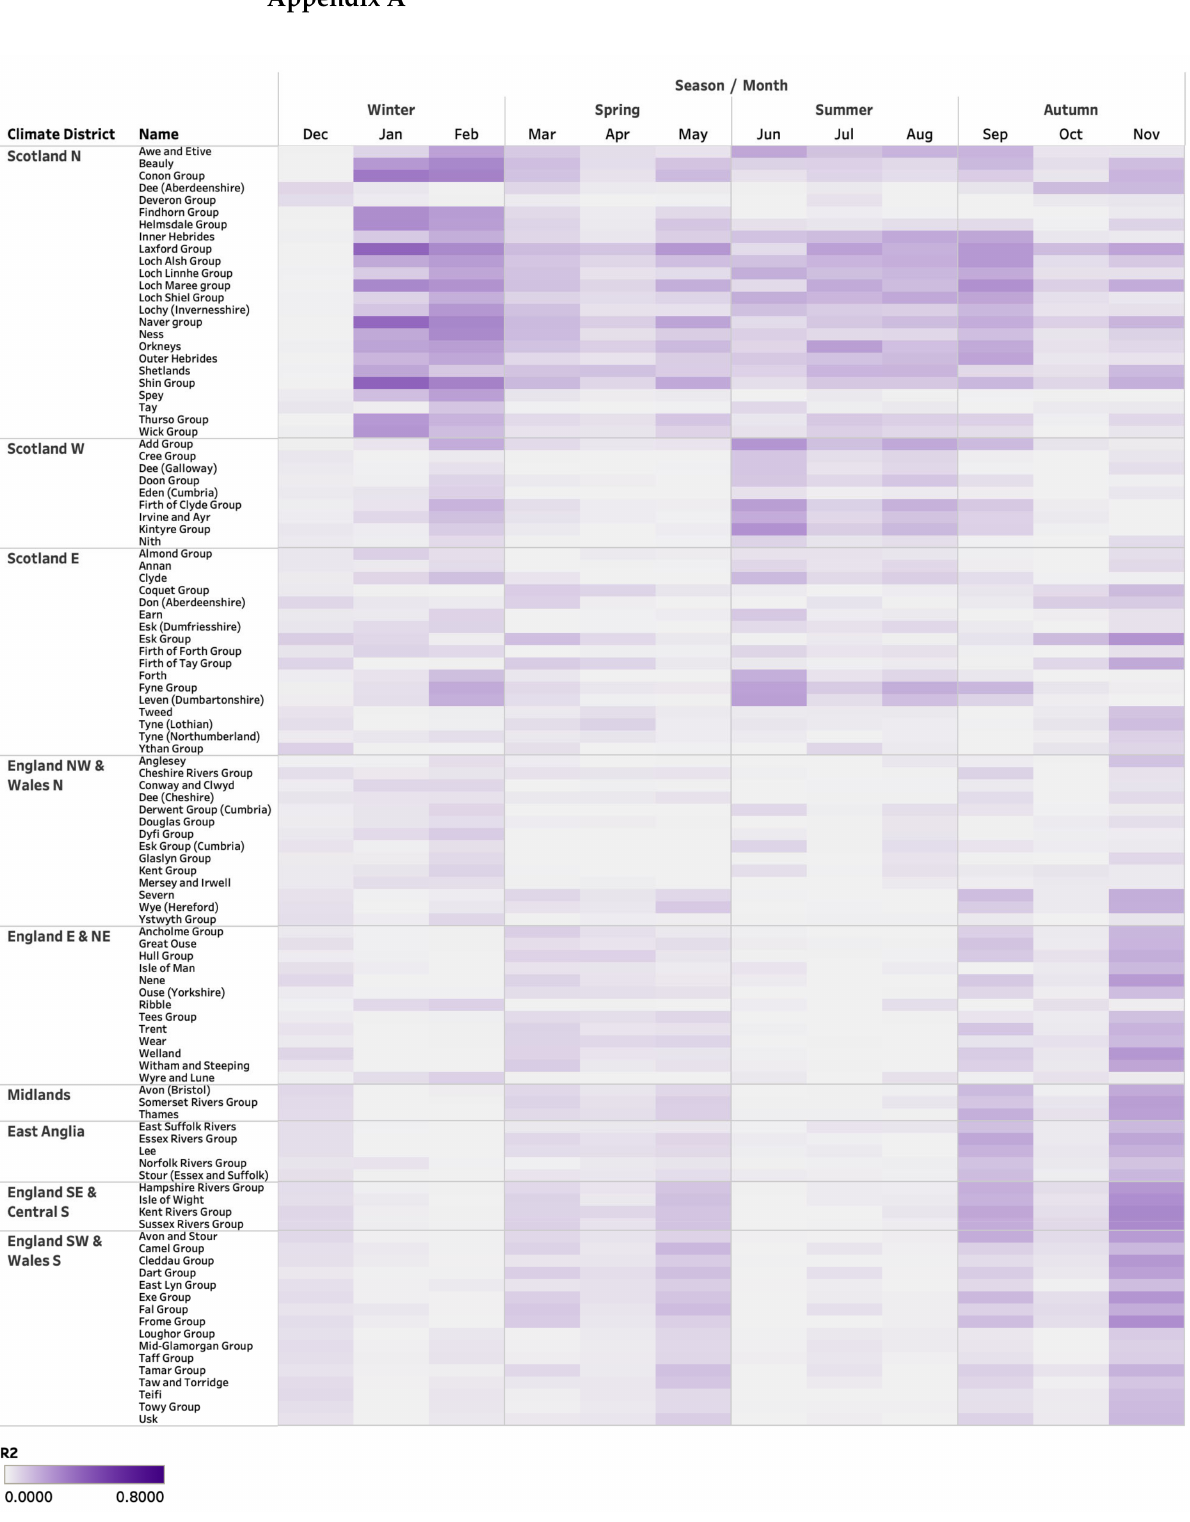
Figure A1. R 2 values of the univariate regression model exploring the relationship between the SCA index and SPI-1 values across the IHU